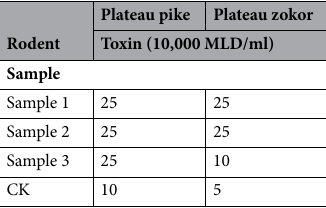
Table 4. Comparative test of the destruction strength of mineralized toxins and pure toxins in the intestinal contents of two kinds of rodents.